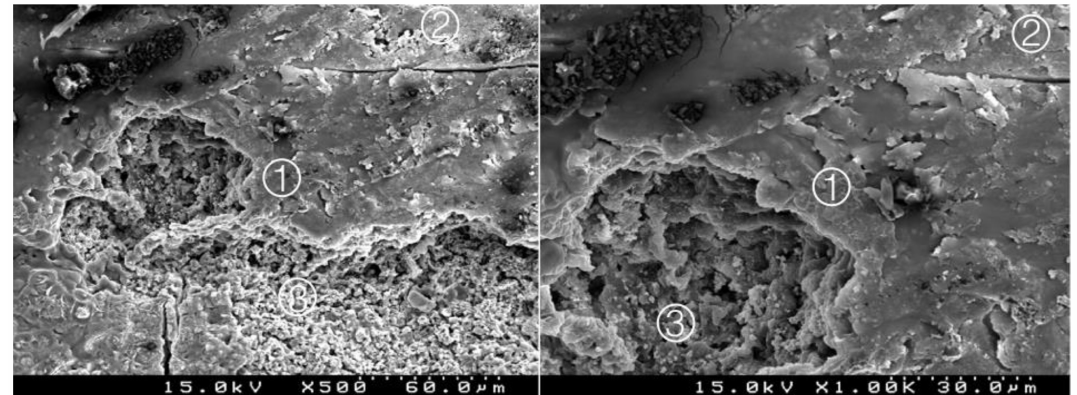
Figure 15. Group 13 (NeoMTAU0I): interpenetration between the adhesive and the cement, with particles of cement involved by the adhesive. A thick interdiffusion layer is presented 1 (cid:13) between the adhesive 2 (cid:13) and the NuSmile ® NeoMTA 3 (cid:13) (original magnification 500 × and 1000 ×